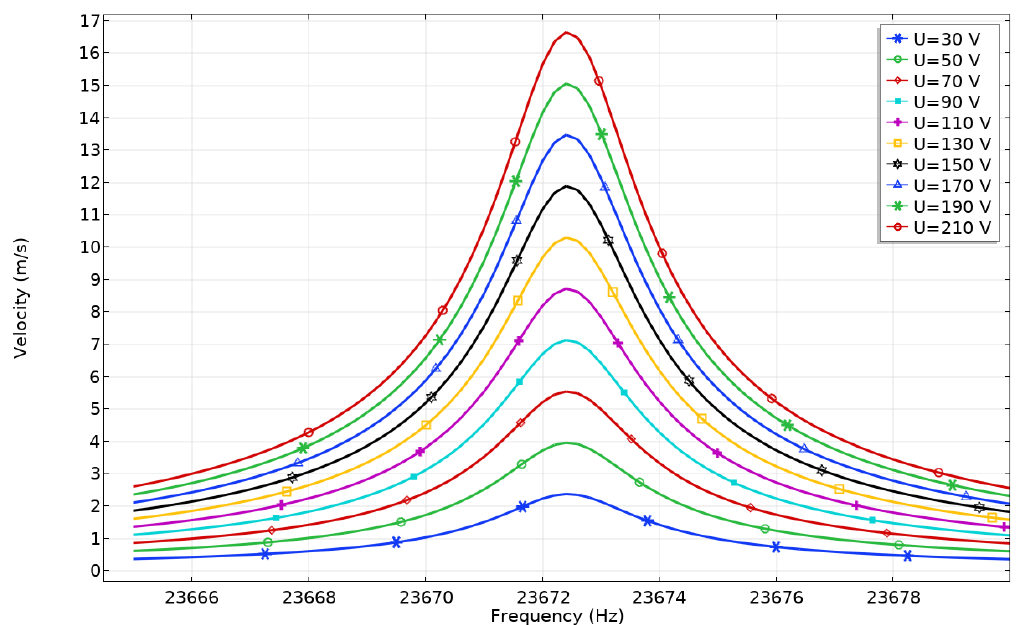
Figure 11. Velocity—frequency characteristics of the platform while different excitation voltages are applied to Plate 1.